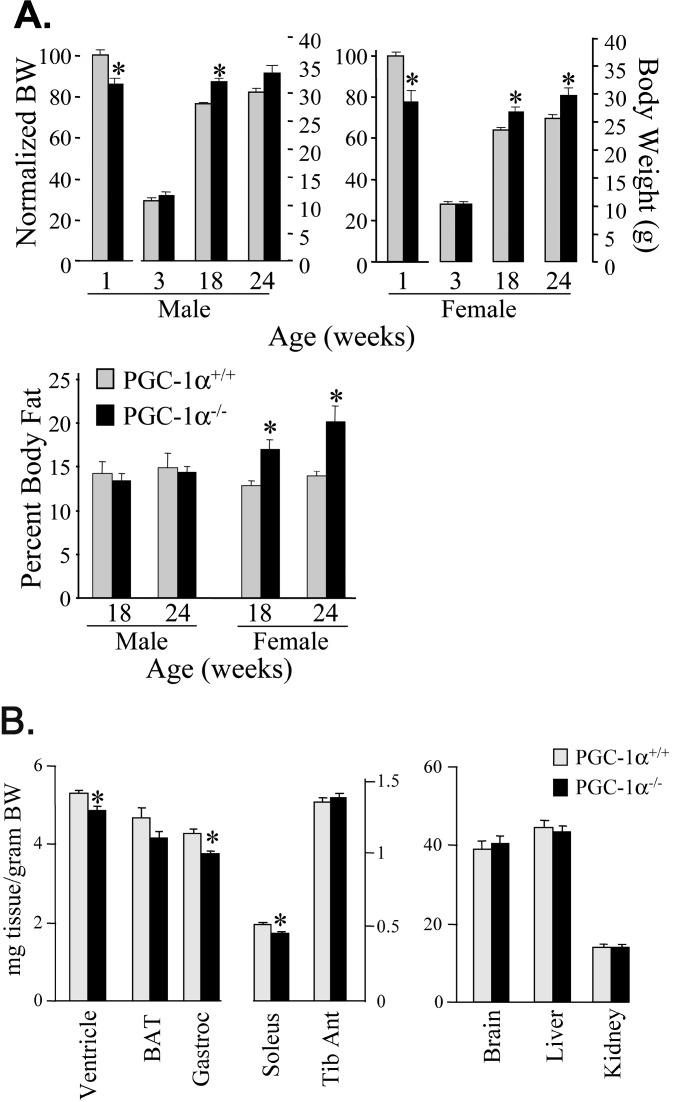
Evidence for Tissue-Specific Growth Abnormalities and Mild Sex-Limited, Age-Dependent Obesity in PGC-1α−/− Mice(A) The bars represent total body weight for the ages indicated for male (left graph) and female (center graph) PGC-1α+/+ and PGC-1α−/− mice. The body weight (BW) of the 1-wk-old PGC-1α−/− mice was normalized to that of PGC-1α+/+ littermates, which was assigned a value of 100 (left axis). For the 3-, 18-, and 24-wk time points, absolute weights of PGC-1α−/− mice were compared to age-matched controls (right axis). Percent fat as determined by DEXA scanning for PGC-1α+/+ and PGC-1α−/− mice (right graph). The results represent n = 4 (males) and n ≥ 11 (females) for each genotype at 24 wk. * p < 0.05 compared to corresponding PGC-1α+/+ mice.(B) The bars represent organ weights corrected to body weight for 3-wk-old male and female PGC-1α+/+ and PGC-1α−/− mice. The error bars represent ± SEM. Results represent n ≥ 14 for each group. * p < 0.05 compared to corresponding PGC-1α+/+ mice.